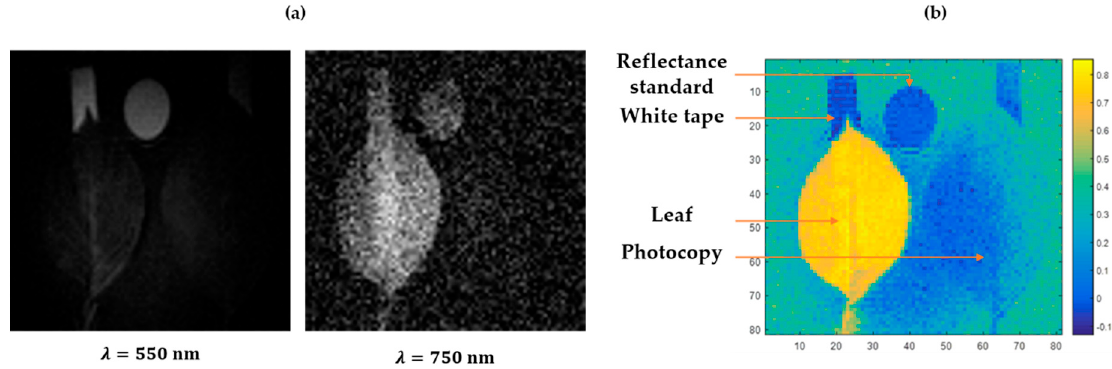
Figure 3. Discrimination of a leaf within a scene. ( a ) Images reconstructed at 550 and 750 nm. ( b ) NDVI mapping of the reconstructed image.